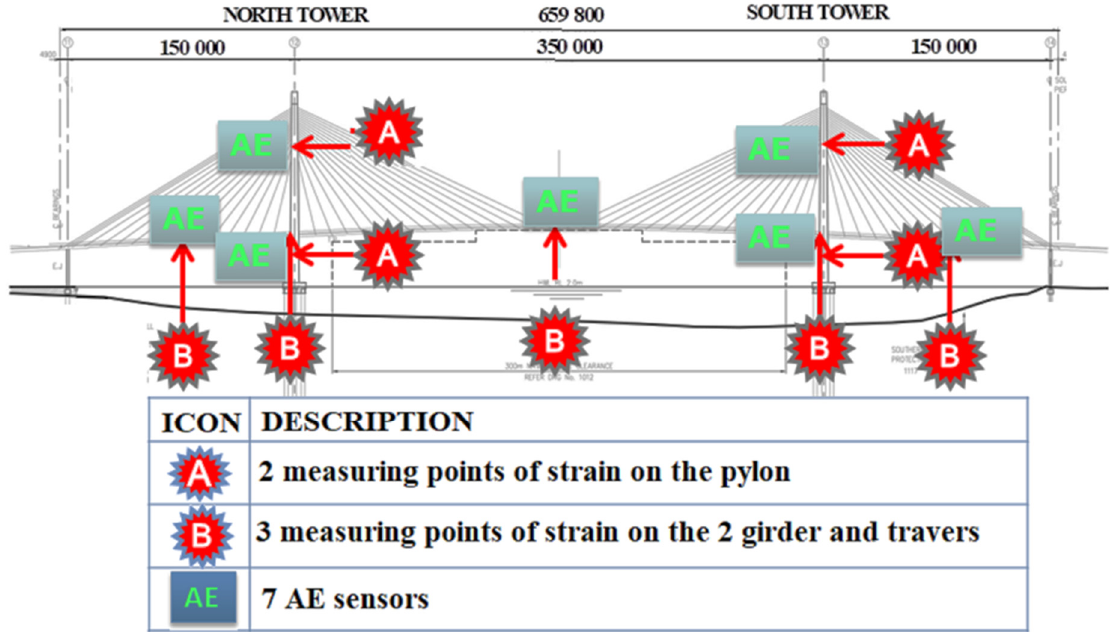
Figure 18. Arrangement of measurement points in the strain measurement system.